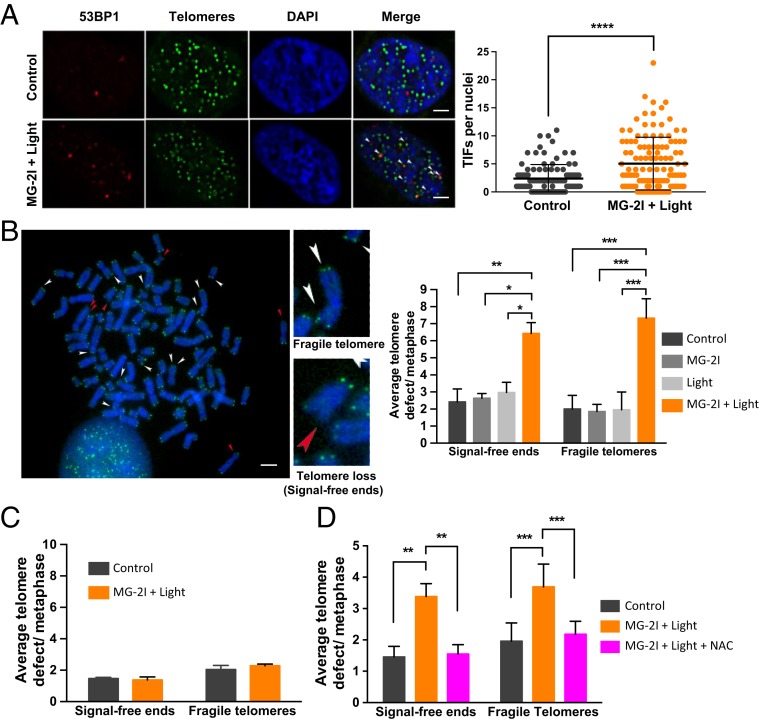
Mitochondrial dysfunction leads to telomere damage. (A) The recruitment of 53BP1 (red) at the telomeres (green) 48 h after MG-2I (50 nM) and light (5-min) treatment was analyzed by immunofluorescence. The number of 53BP1+/PNA+ TIFs was quantified. Data are represented as mean ± SD. ****P < 0.0001. (Scale bars: 2 μm.) (B) The number of HEK293 Mito-FAP cells with fragile telomere and telomere loss (signal-free ends) was evaluated by FISH 48 h after MG-2I (50 nM) and light (5-min) treatment. Data are represented as mean ± SD. (Scale bar: 2 μm.) (C) Telomere damage in HEK293 Mito-FAP ρ0 cells was analyzed as described in B. Data are represented as mean ± SD. (D) HEK293 Mito-FAP cells were pretreated with NAC (10 mM) for 15 min before, during and after light (5-min) exposure, and their telomere damage was then analyzed as in B. Data are represented as mean ± SD. At least 50 cells were counted. Representative results from 3 independent experiments are shown. *P < 0.05, **P < 0.01, ***P < 0.001.